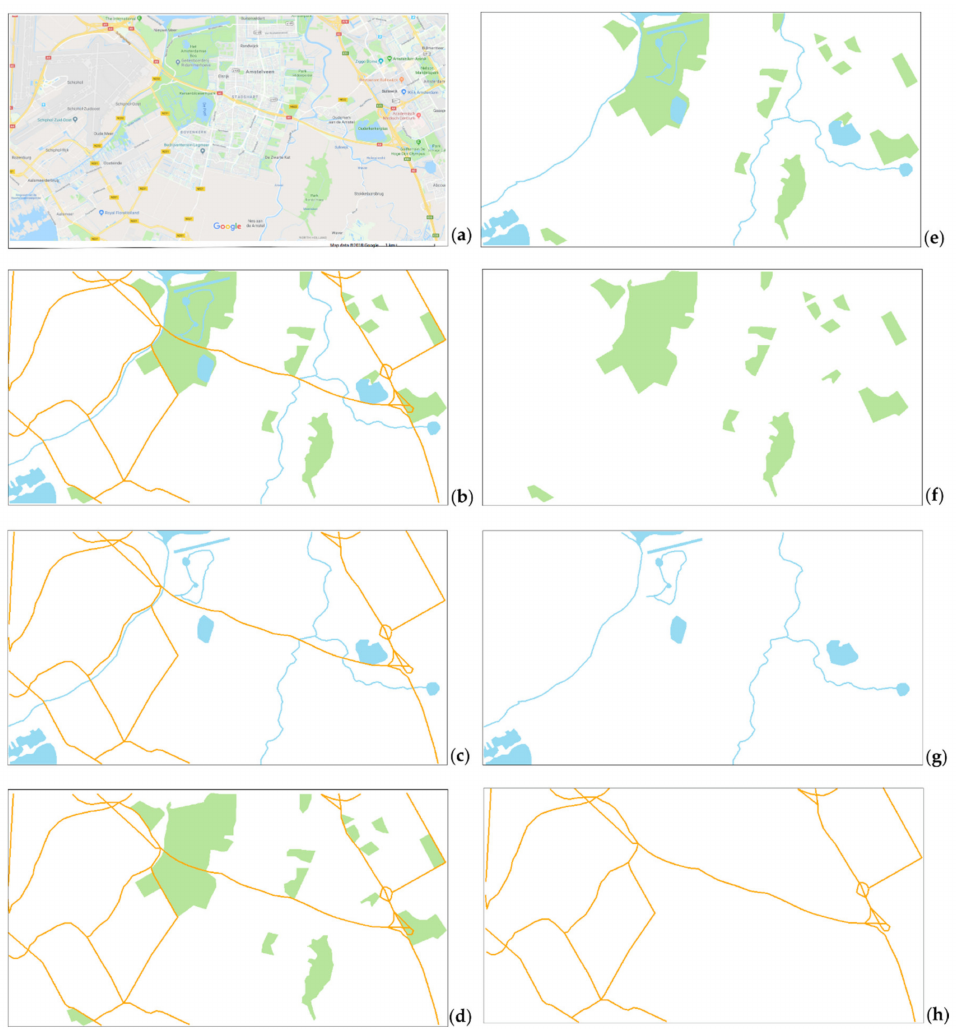
Figure 1. Example stimulus and experiment blocks: ( a ) original stimulus; ( b) Block 1: all map elements; ( c ) Block 2: roads and hydrography; ( d ) Block 3: roads and green areas; ( e ) Block 4: green areas and hydrography; ( f ) Block 5: green areas; ( g ) Block 6: hydrography; ( h ) Block 7: roads (modified from